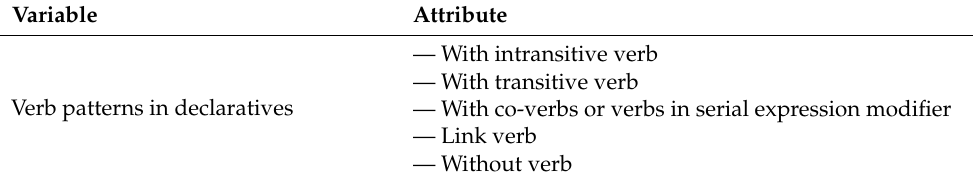
Verb patterns in